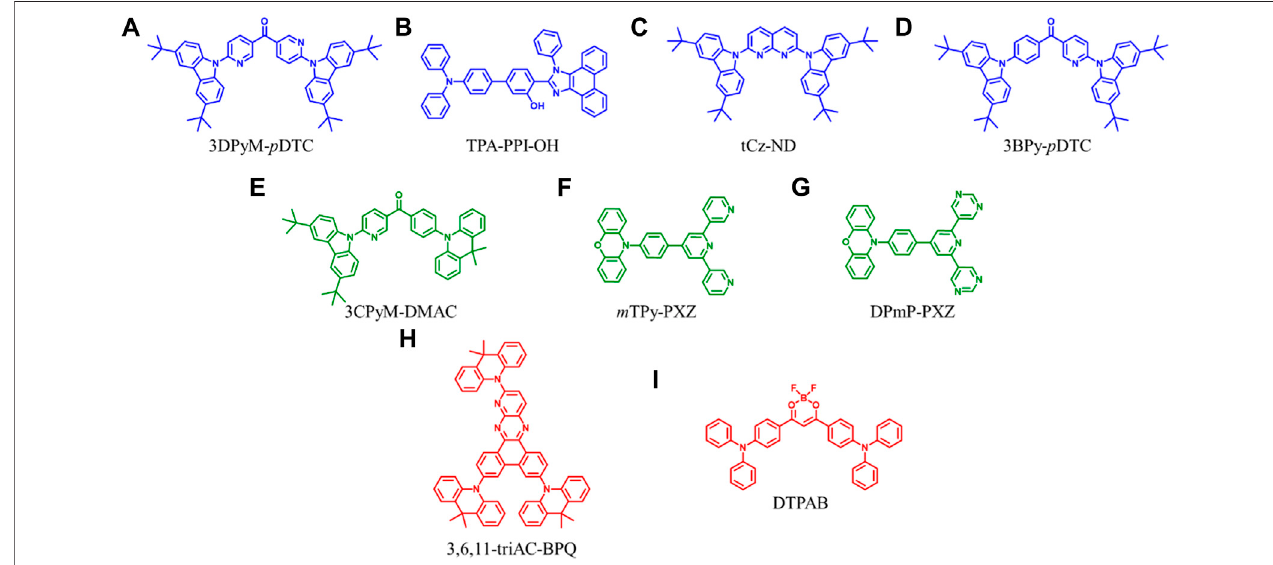
FIGURE 1 | Chemical structures of the OLED materials possessing intra/intermolecular H-bond interactions.